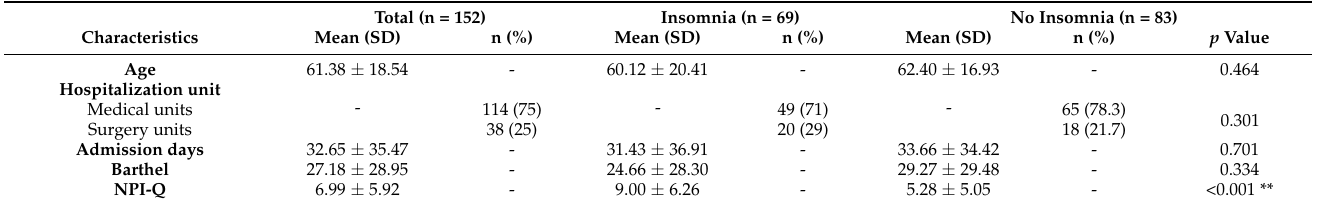
Table 2. Distribution of patient characteristics according to the presence of caregivers’ insomnia